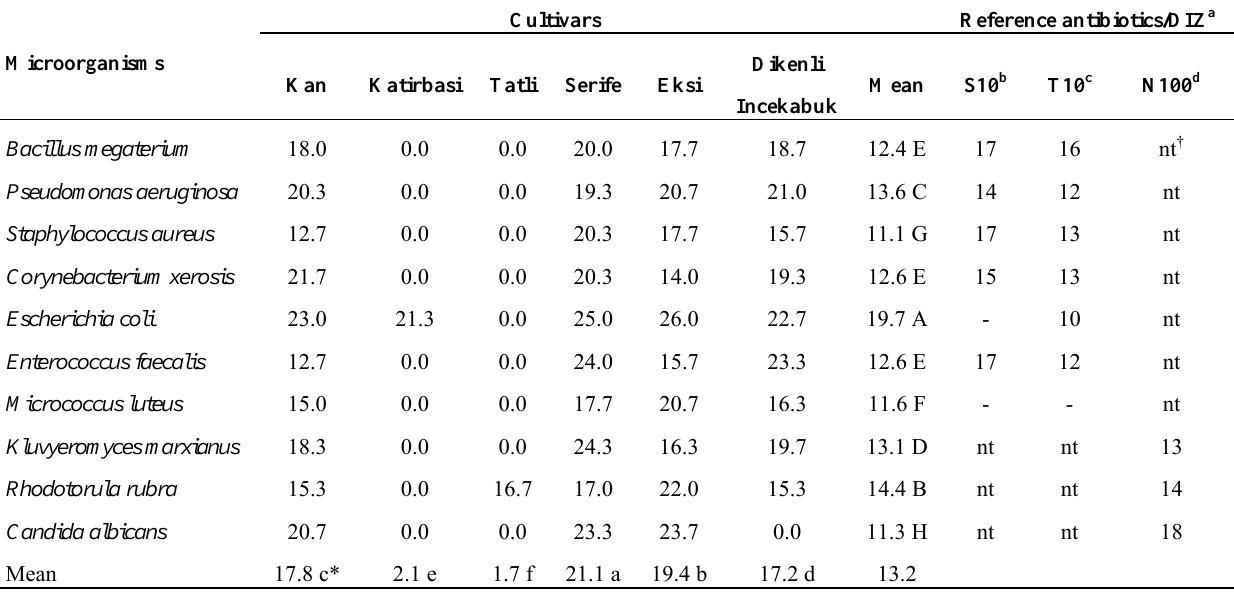
Table 2 . Inhibition zones (mm) on several microorganisms caused by six pomegranate cultivars and some positive antibiotics exhibiting their antimicrobial